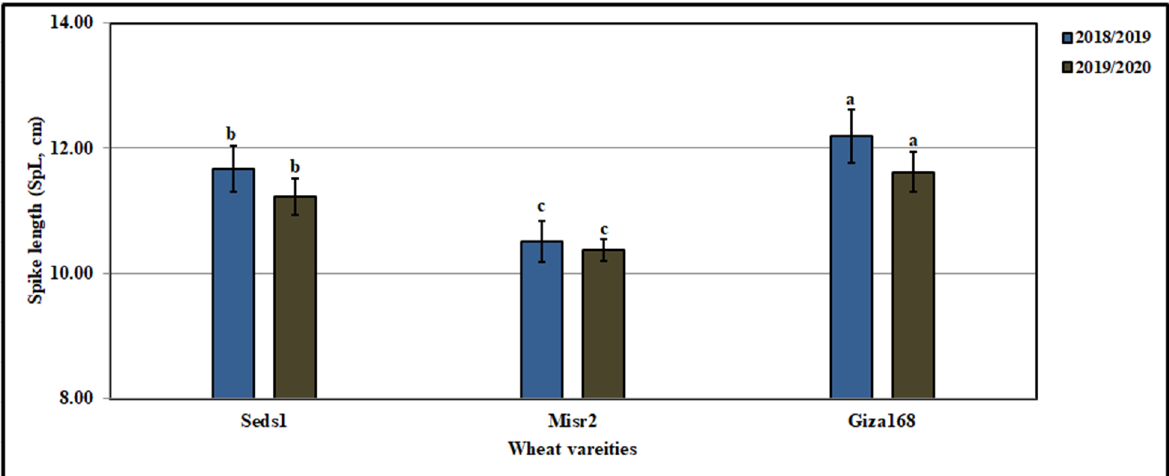
Figure 10. Influence of wheat varieties on spike length (SpL, cm) in clay loam soil in 2018/2019 and 2019/2020 seasons. Bars in the same years with a different letter indicate significant differences between treatments at p ≤ 0.01. HS 1, HS 2 , HS 3 represent HS applied as foliar spray at 1.0, 2.0, 4.0 g L − 1 , respectively, HS 4 , HS 5 , HS 6 represent HS applied as soil application at 5.04, 7.56, 10.08 kg ha − 1 .